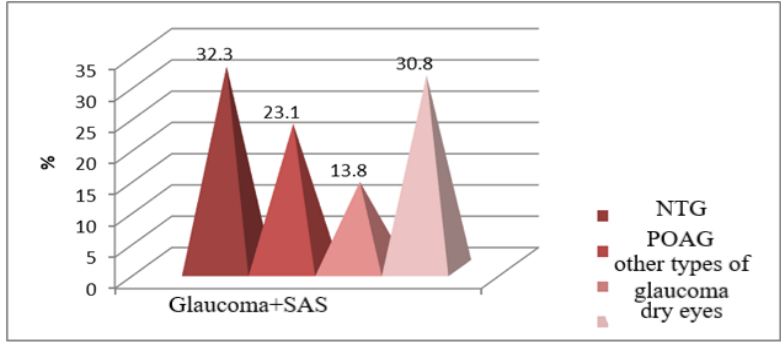
Figure 1. Distribution of patients with SAS by types of glaucoma.